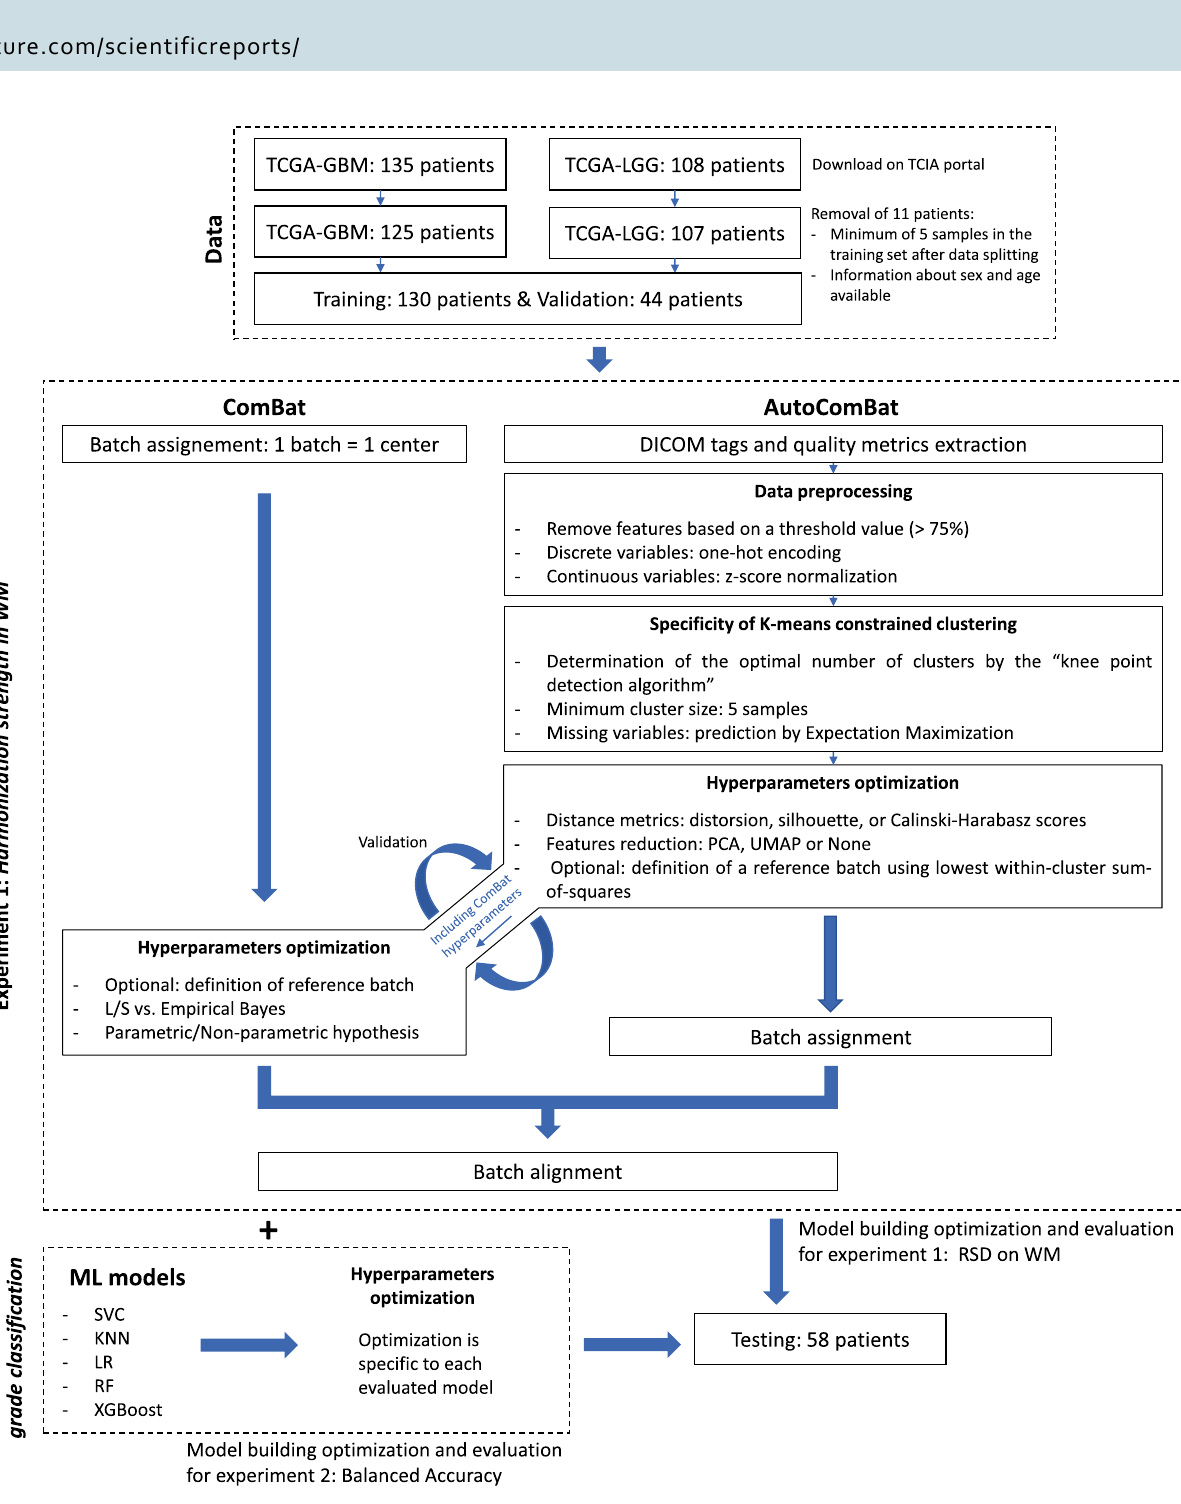
Figure 2. Workflows for the ComBat and AutoComBat computation models. These workflows are performed after extraction of the radiomic